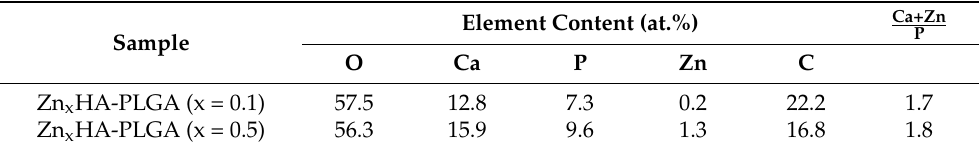
Figure 4. SEM images of composites: ( a ) Zn x HA-PLGA (x = 0.1), ( b ) Zn x HA-PLGA (x = 0.5) and the quantitative distribution of particles over the surface: ( c ) Zn x HA-PLGA (x = 0.1), ( d ) Zn x HA-PLGA (x = 0.5) .